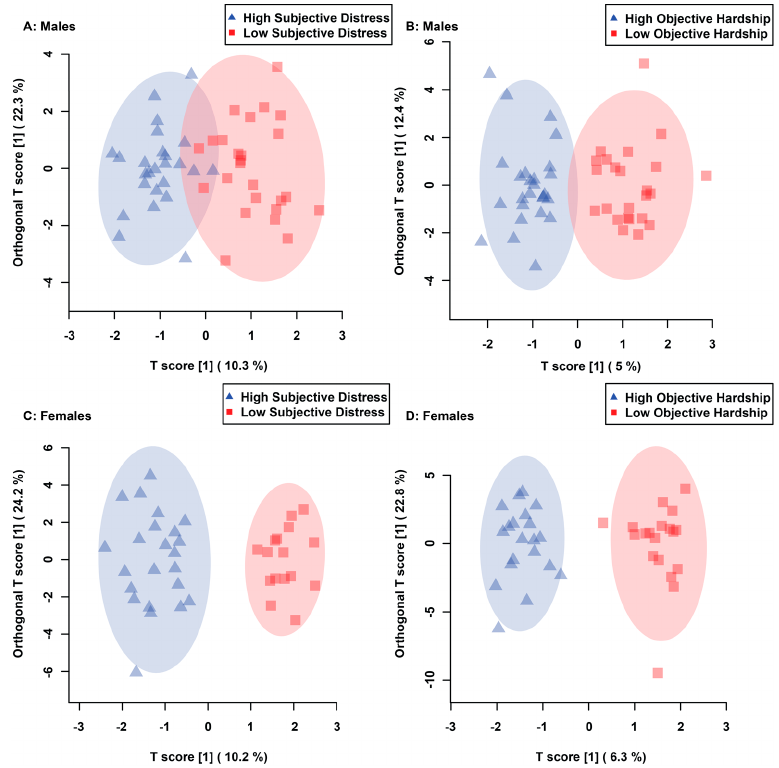
Figure 1. Orthogonal Projections to Latent Structures Discriminant Analysis (OPLS-DA) score plots representing the statistically signi fi cant supervised separation of maternal composite subjective dis- tress in males ( A ), maternal objective hardship in males ( B ), maternal composite subjective distress in females ( C ) and maternal objective hardship in females ( D ) comparisons. Each triangle and square represent one individual, plo tt ed using urinary metabolites found to be statistically signi fi - cant by VIAVC testing. Shaded ellipses represent the 95% con fi dence interval. The x-axis represents between-group (predictive) variation, whereas the y-axis represents within-group (orthogonal) var- iation.